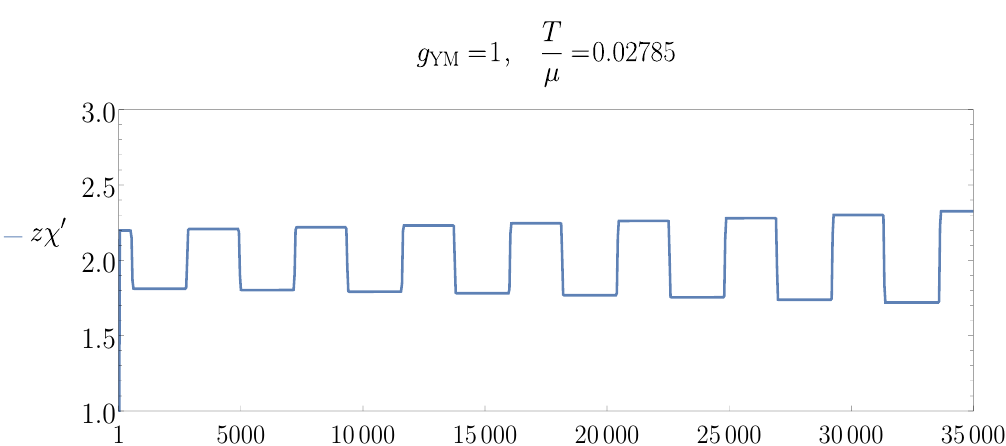
Figure 19. Large- z plot for zχ 0 at ω h 0 = 2 . 713 . The function once again demonstrates a large number of oscillations at this ω h 0 . The function is also shown to oscillate around zχ 0 = 2 or analogously n h = 1 .